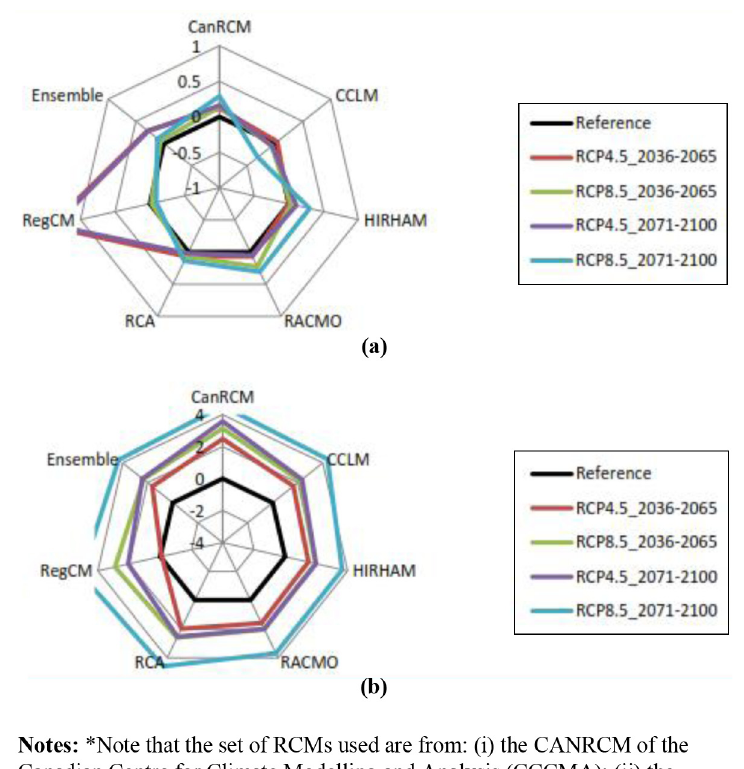
Figure 2. Absolute temperature and precipitation changes (in °C and mm d (cid:5) 1 ) for both the climate scenarios RCP4.5 and RCP8.5 and for two future time windows 2036- 2065 and